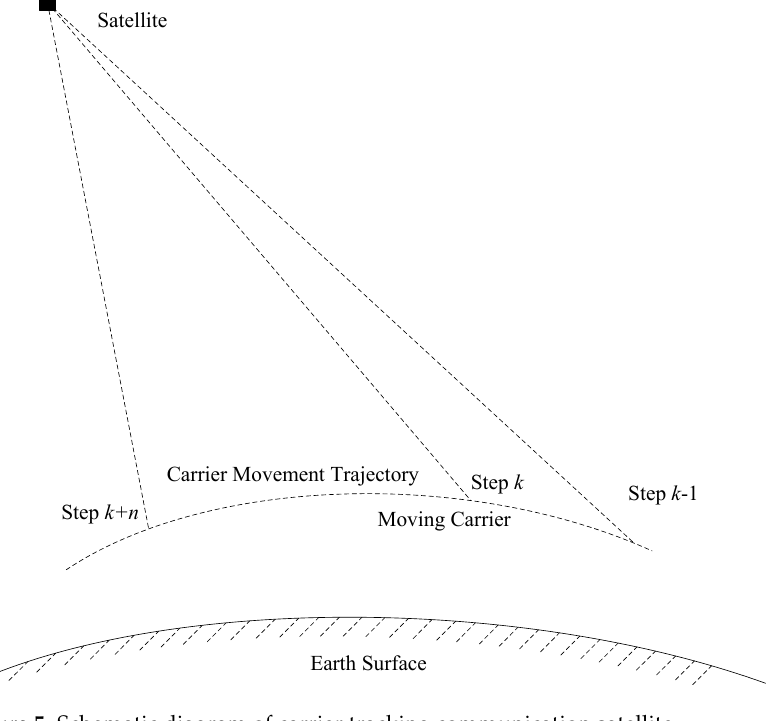
Figure 5 is a schematic diagram of the process of carrier tracking communication satellites. Since the system uses digital electronic devices, we need to obtain a discrete-time model, where ∆ t represents the sampling time interval; each tracking datum has a time mark, k represents the time sequence, and the tracking time sequence is shown in Figure 6.